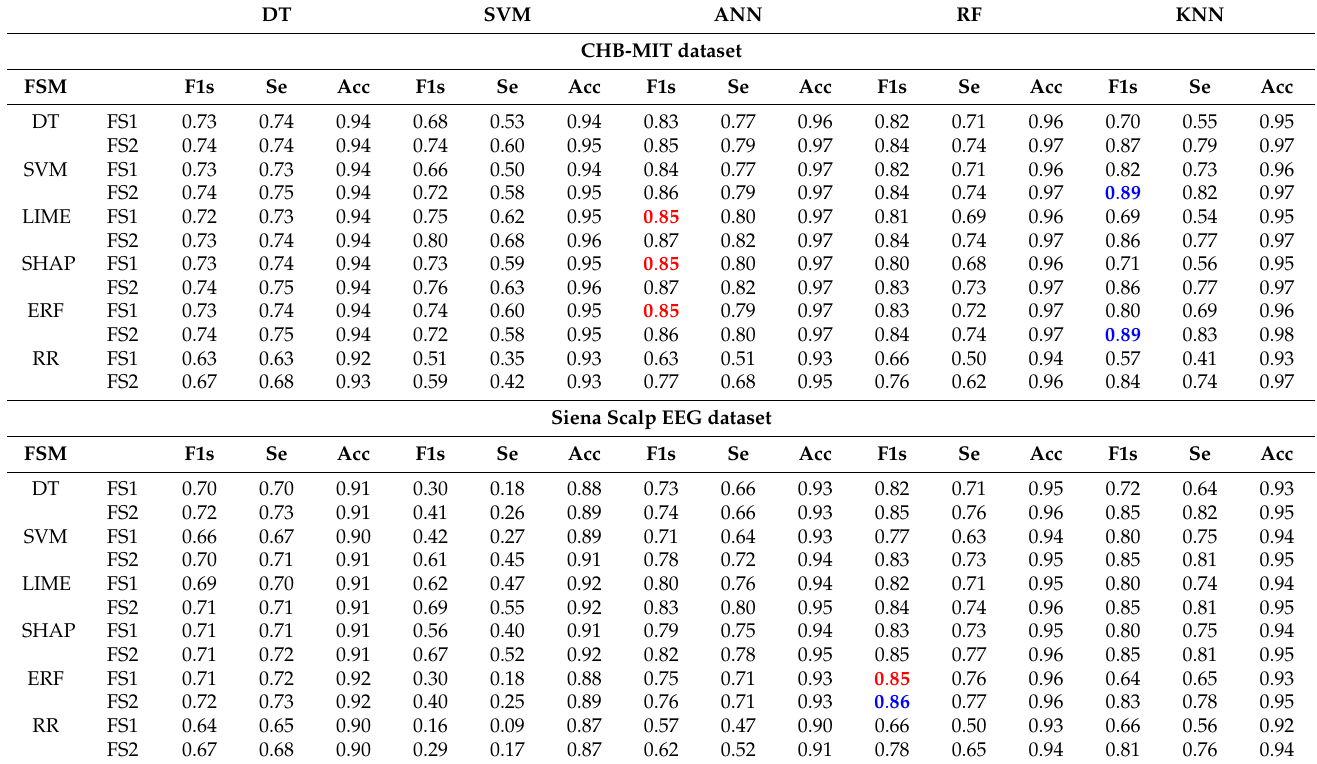
Table 7. Performance comparison using 150 features. The largest F1-scores are displayed in red bold and blue bold for FS1 and FS2, respectively. F1s = F1-score, Se = sensitivity, Acc = accuracy.